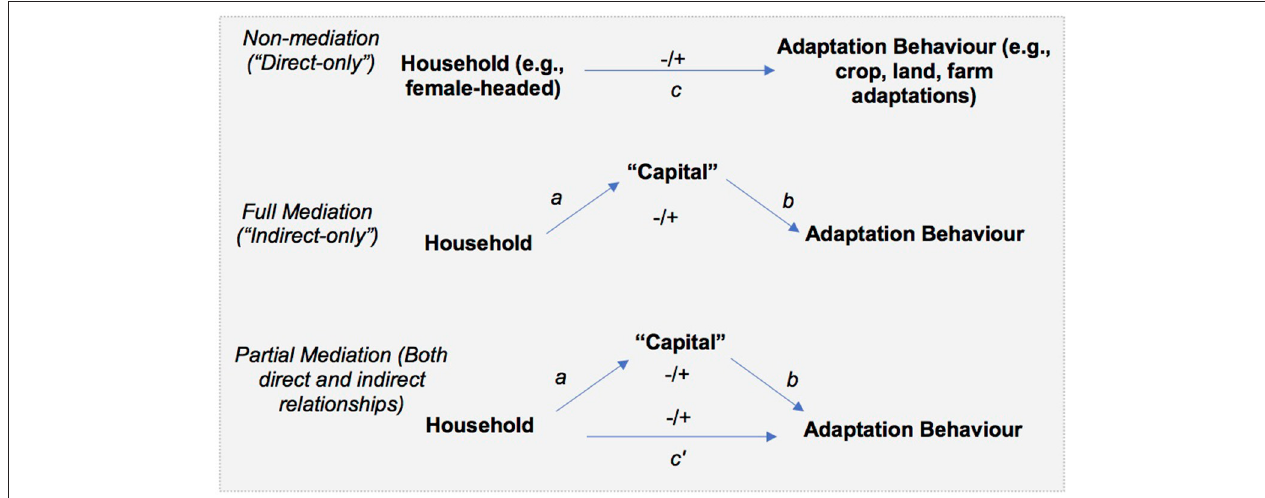
FIGURE 2 | Diagram illustrating different mediation effects. Top: Non-mediation or the total effect ( c ). Middle: Full mediation ( a × b ); Bottom: Partial mediation where the indirect path ( a × b ), or the mediated effect explains only some of the relationship. Adapted from Zhao et al. (2010).